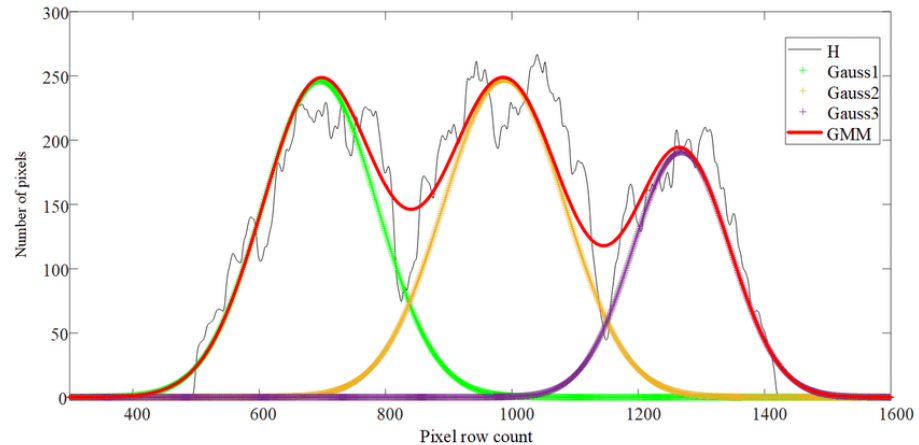
Figure 8. Gaussian Mixture Models [96].